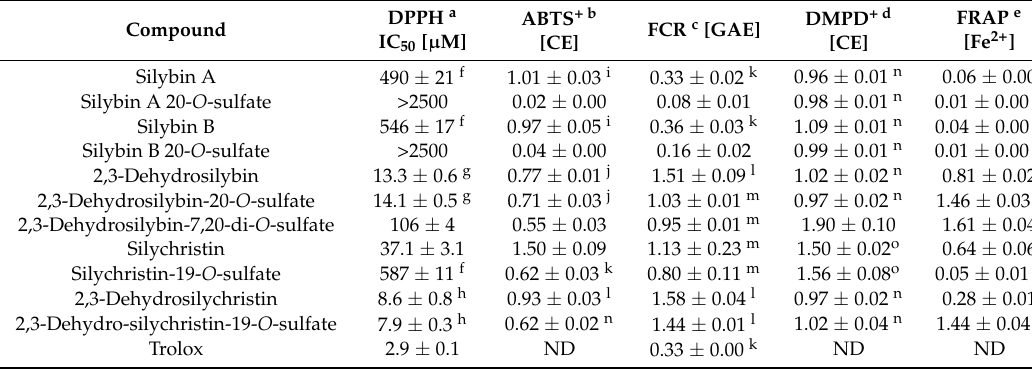
Table 3. Radical scavenging and reducing capacity of flavonolignan sulfates in comparison with non-conjugated